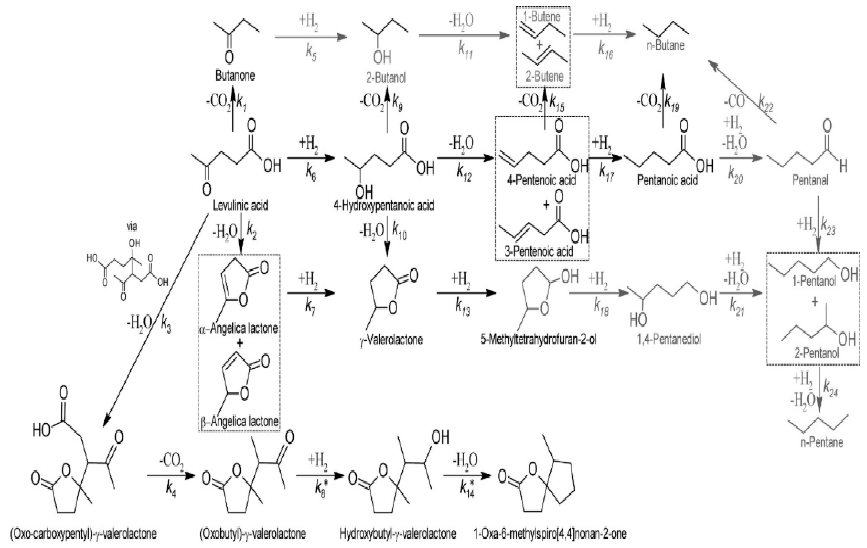
Figure 11. Reaction mechanism for the HDO of levulinic acid. Reprinted from reference [87].